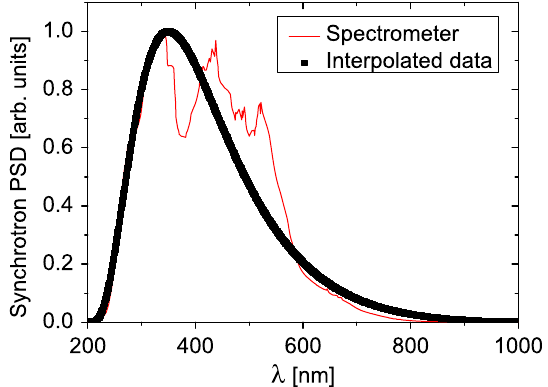
FIG. 17. Squared modulus of the radiation CDC as measured with the HNFS technique. Data from the 9 different sample- detector distances shown in Fig. 16 have been merged through Eq. (13) and binned. Inset shows the corresponding upper and lower envelopes. By contrast with Fig. 13, the short coherence time of the radiation makes any tapering effect negligible, as the loss of Talbot visibility and the decay of power spectra to shot noise level are entirely due to the radiation CDC.